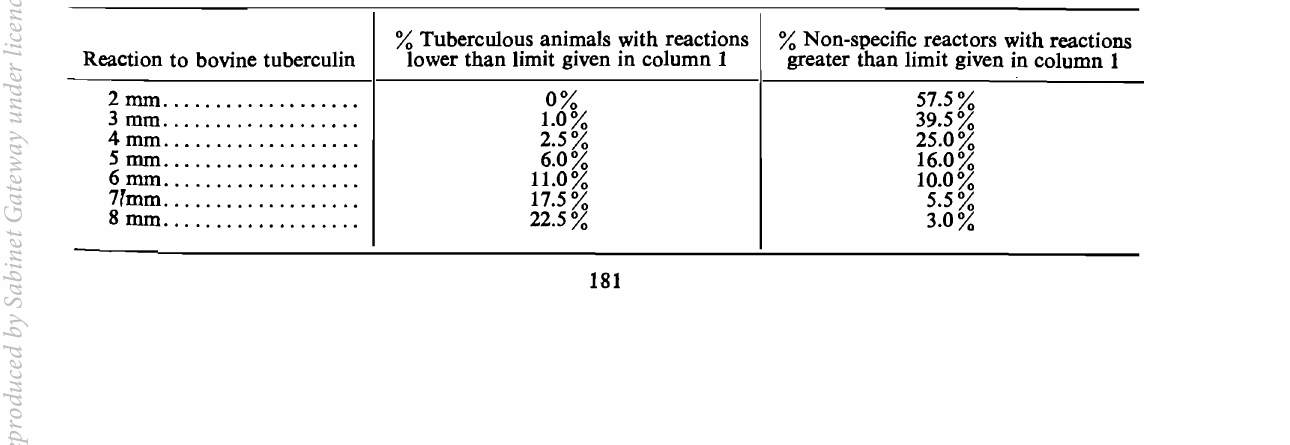
culous cattle that would be classed as negative, and the percentage of non-specific reactors that would be classed as positive at any level can also Fig. 5. From these curves the percentage of tuber- be determined. These figures are given in Table 2. TABLE 2.-DIAGNOSTIC ACCURACY OF THE TUBERCUliN TEsT USING BOVINE TUBERCULIN ALONE.